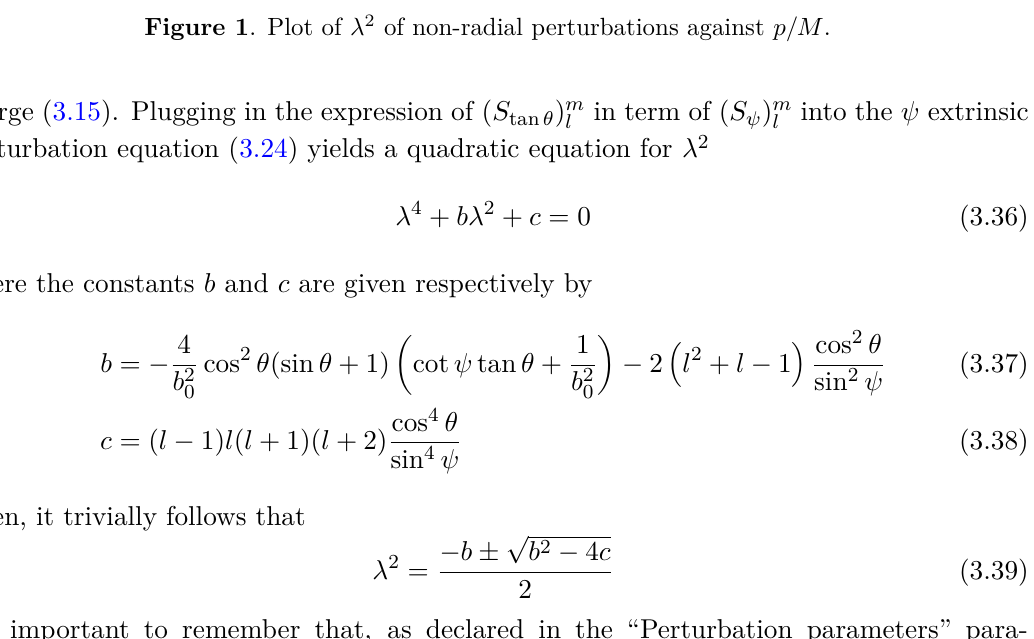
Figure 1 . Plot of λ 2 of non-radial perturbations against p/M